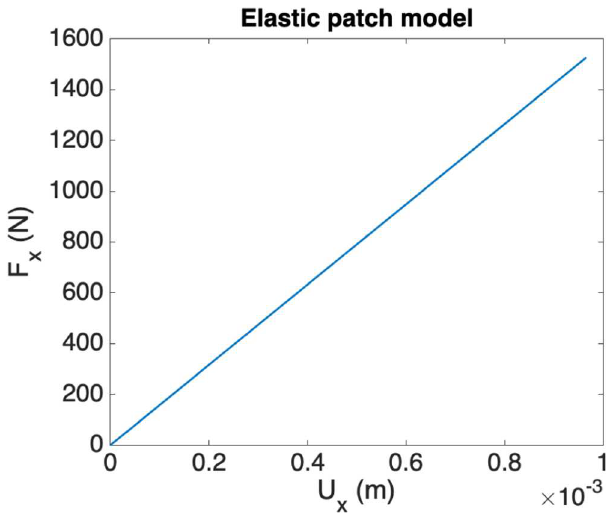
Fig. 14. Applied force versus induced displacement on the patch surface x = H ω x .